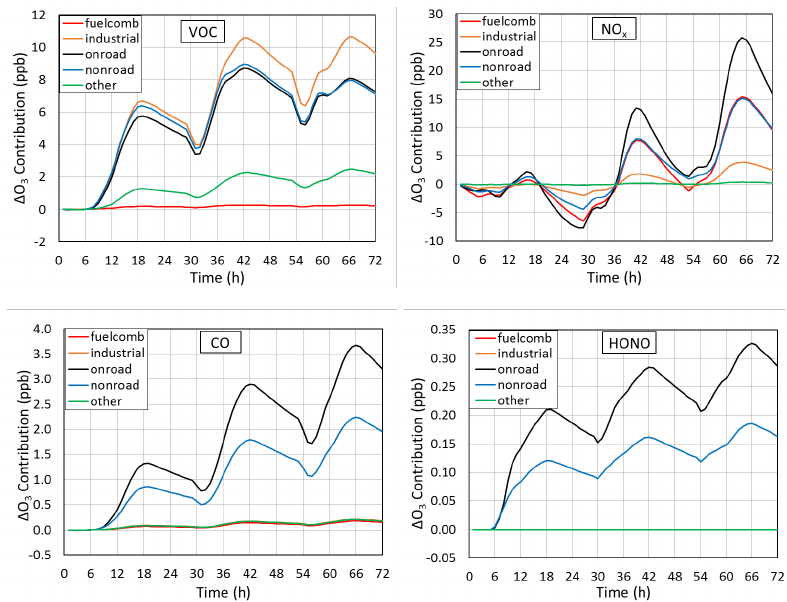
Figure 4. Contributions of sources and VOC, NO x , CO, and HONO emissions to the anthropogenic O 3 increment. Results are for the Diag